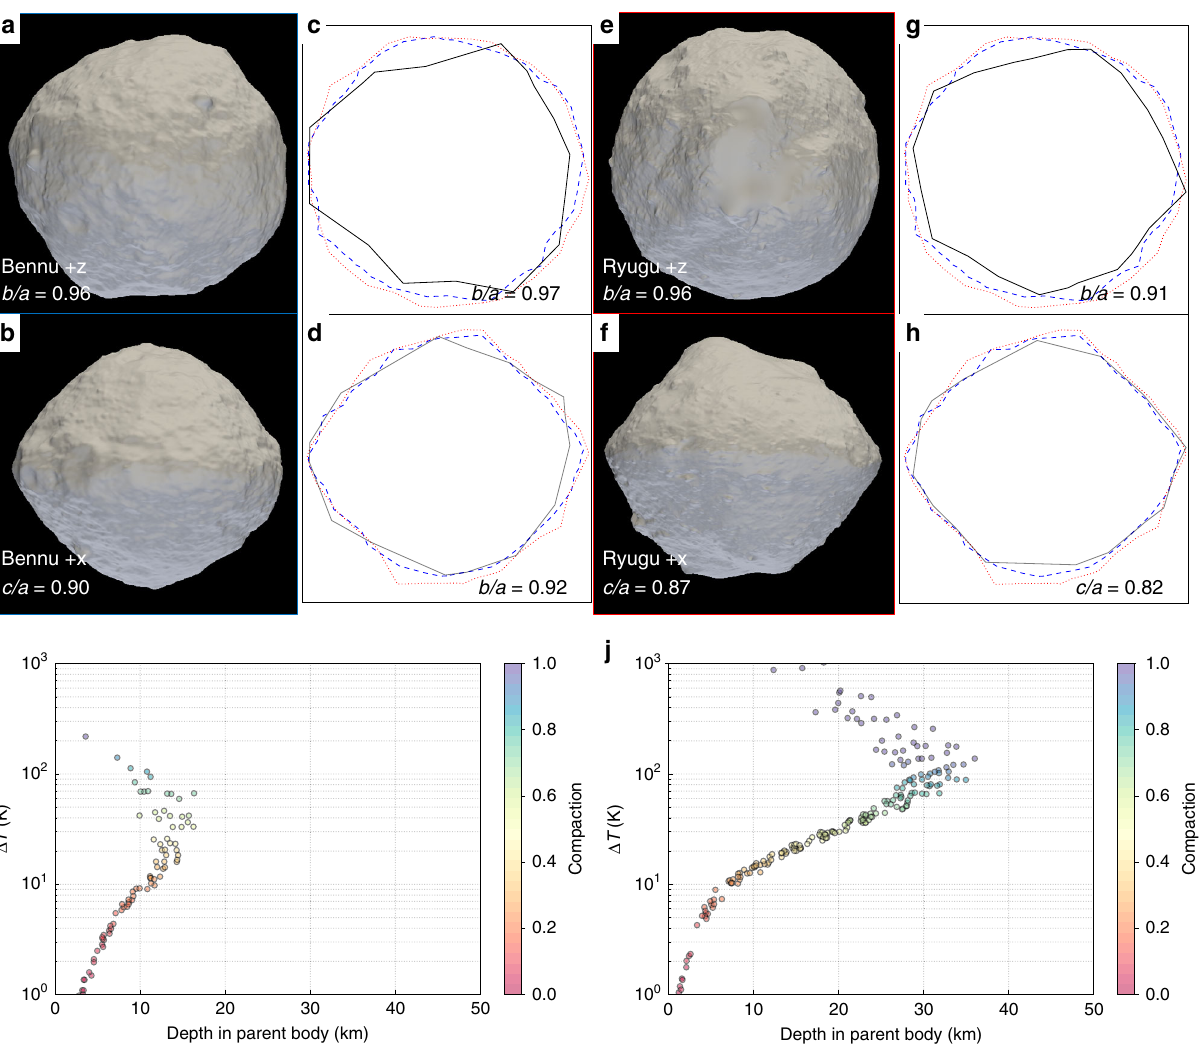
Fig. 2 Reaccumulated aggregates can resemble Bennu and Ryugu. a – h Comparison of the Bennu ( a , b ) and Ryugu ( e , f ) shape models 1,9 and the shape pro fi les of two reaccumulated aggregates ( c , d , g , h ) from simulation 3 (Table 1). The panels a , c , e , g show the pro fi le of each shape from a polar view, and the panels ( b , d , f , h ) show the pro fi les from an equatorial view. The shapes of the reaccumulated remnants are traced in black and are compared to the traced shapes of Bennu (blue dashed line) and Ryugu (red dotted line). i The temperature change, Δ T ( y- axis), the original depth in the parent body ( x - axis), and the degree of compaction (color, unitless) of each particle that makes up the simulated aggregate shown in ( c ) and ( d ). j The same properties as in i are shown for the simulated aggregate shown in ( g ) and ( h ). i , j The particles that experience the most heating and compaction originate near the surface, close to the impact point. Those experiencing the least heating and compaction also originate near the surface, but closer to the antipode of the impact. Although the two reaccumulated remnants (shown in c , d , g , h ) have very similar shapes, they apparently have different thermal histories. Comparing i and j , we fi nd a clear difference in the peak and average temperature change and the degree of compaction experienced by the material that formed these two aggregates. Furthermore, the aggregate shown in g and h is composed of material that is sampled from a larger maximal depth within the parent